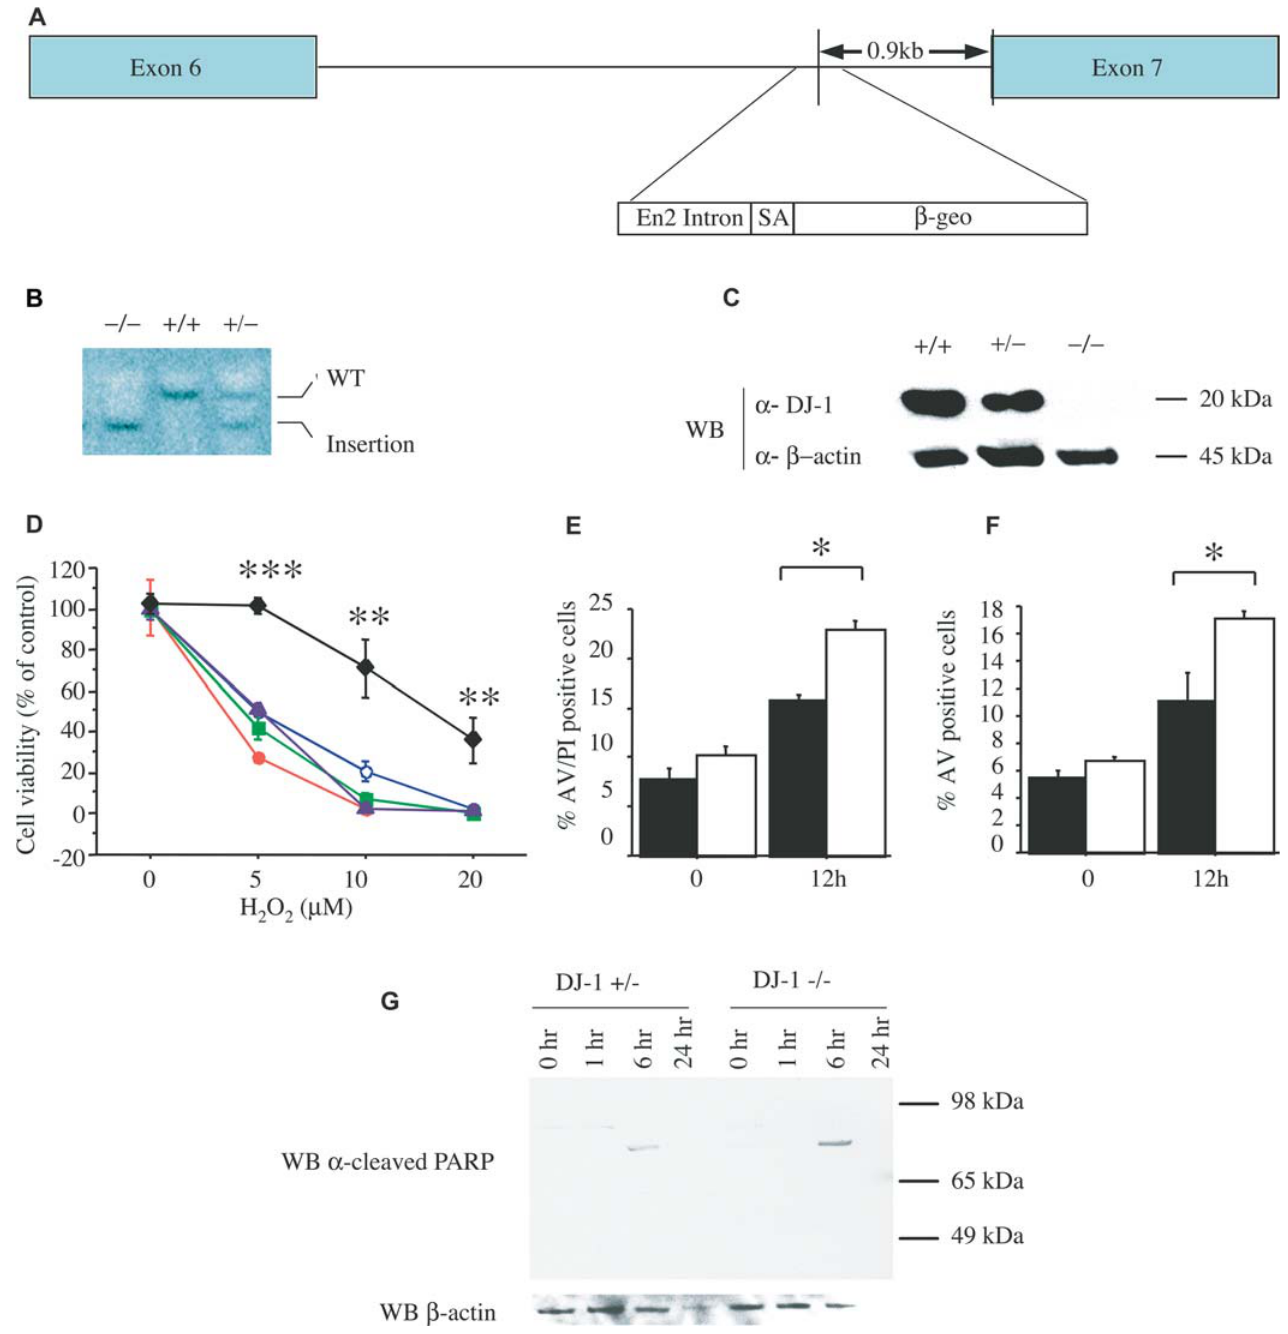
Figure 1. DJ-1-Deficient ES Cells Are Sensitized to Oxidative Stress (A) Schematic map of the murine DJ-1 gene in clone F063A04. The retroviral insertion places the engrailed-2 (En2) intron, the splice acceptor (SA), and the b -galactosidase/neomycin resistance gene fusion ( b -geo) between exons 6 and 7. (B) Southern blot analysis of KpnI-digested genomic DNA from DJ-1 homozygous mutant (–/–), WT ( þ / þ ), and heterozygous ( þ /–)cells, probed with murine DJ-1 cDNA. WT DNA shows a predicted 14-kb band (WT), whereas the mutant allele migrates as a 9-kb band (insertion). (C) Western blot (WB) of ES cell lysates from WT ( þ / þ ), DJ-1 heterozygous ( þ /–), and mutant homozygous (–/–) clones with antibodies to murine DJ-1 ( a -DJ-1) or b -actin ( a - b -actin). DJ-1 migrates at 20 kDa, b -actin at 45 kDa. (D) ES cells were exposed to 0, 5, 10, and 20 l M H 2 O 2 for 15 h and viability was assayed by MTT. Responses of DJ-1 heterozygous cells (diamonds) and DJ-1 knockout clones 9 (open circles), 16 (solid circles), 23 (squares), and 32 (triangles) are shown. ** p (cid:1) 0.01; *** p (cid:1) 0.0001. (E and F) Cell death of DJ-1 heterozygous and DJ-1-deficient cells (clone 32) after exposure to H 2 O 2 (10 l M) was quantified by staining with PI and an antibody to AV with subsequent FACS analysis. AV staining marks cells undergoing apoptosis, whereas PI staining indicates dead cells. * p (cid:1) 0.05. (G) DJ-1 heterozygous ( þ /–) and knockout (clone 32; –/–) cells were assayed at 1, 6, and 24 h after treatment with 10 l M H 2 O 2 by Western blotting for cleaved PARP (89 kDa), which indicates apoptosis. No band is seen for cleaved PARP or b -actin for the DJ-1-deficient cells at 24 h due to cell death. Data represent means 6 standard error of the mean (SEM) and were analyzed by ANOVA with Fisher’s post-hoc test. DOI: 10.1371/journal.pbio.0020327.g001 PLoS Biology |